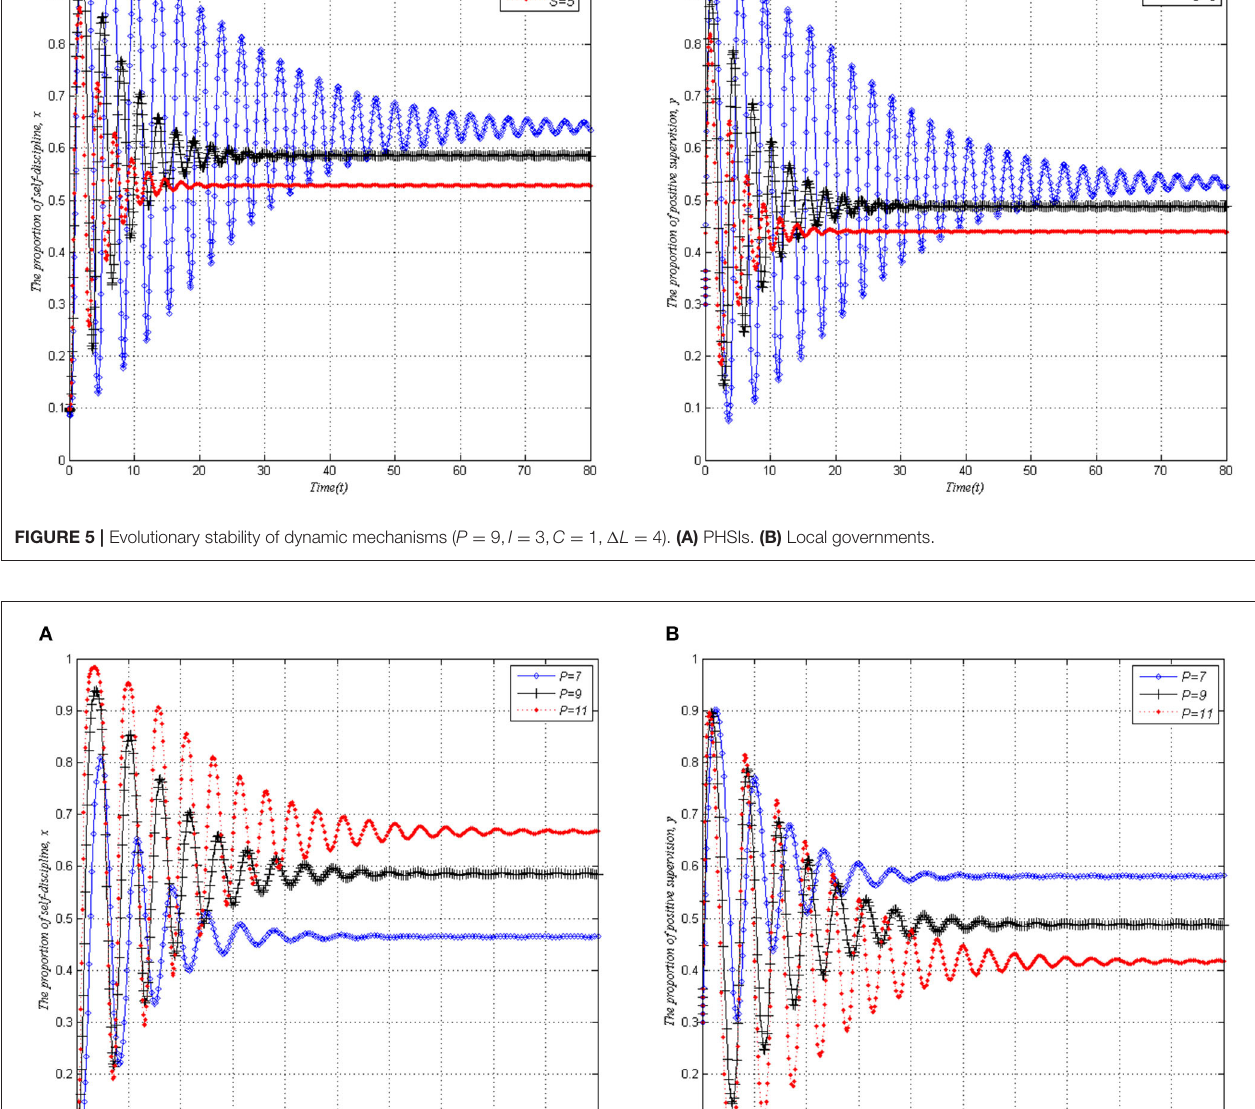
FIGURE 6 | Evolutionary stability of dynamic mechanisms ( S